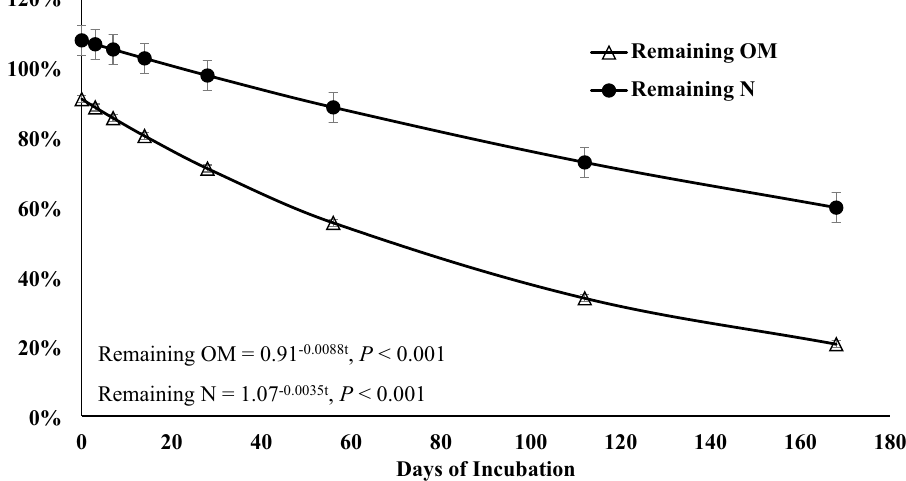
Figure 1. Remaining biomass (OM) and remaining N of rhizoma peanut roots and rhizomes during a 168-days incubation period. The values represent the averages of two treatments (grazed and non-grazed) and 2 years. Bars refer to the